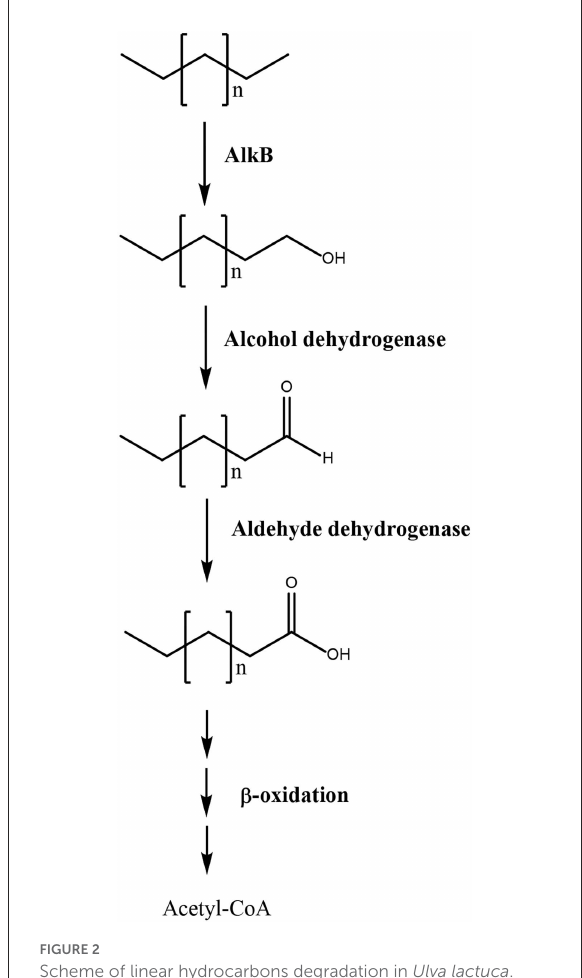
FIGURE2 Scheme of linear hydrocarbons degradation in Ulva lactuca . Pathway 3 involves alkane monooxygenase (alkB), alcohol dehydrogenase, and aldehyde dehydrogenase that oxidize the carboxy terminal methyl group of alkanes to a hydroxyl, aldehyde, and carboxylic acid group, thus producing fatty acid that are metabolized by β -oxidation pathway to produce acetyl-CoA that enter the TCA